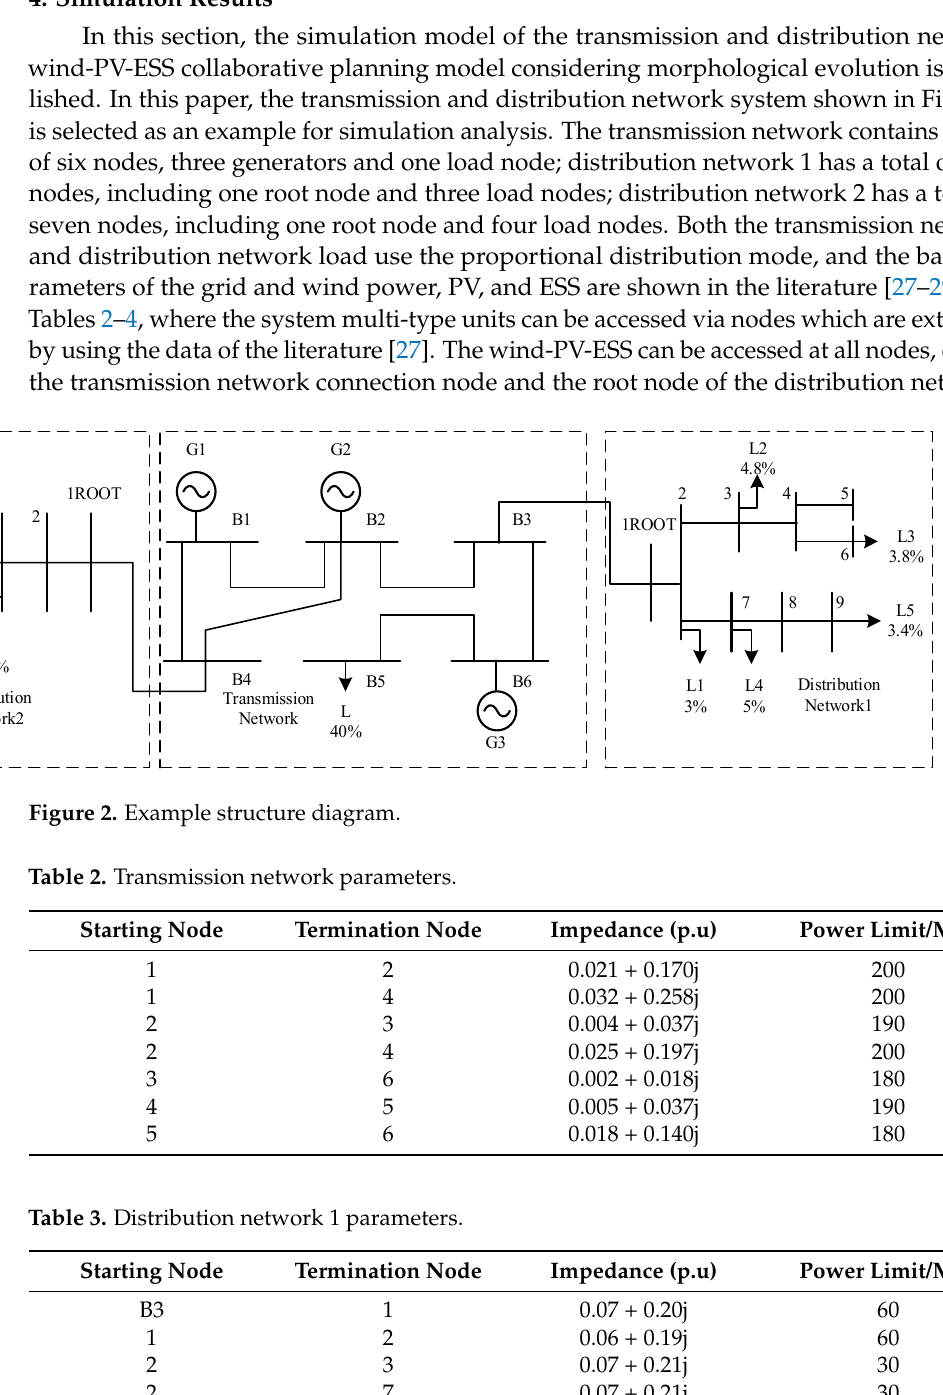
Table 3. Distribution network 1